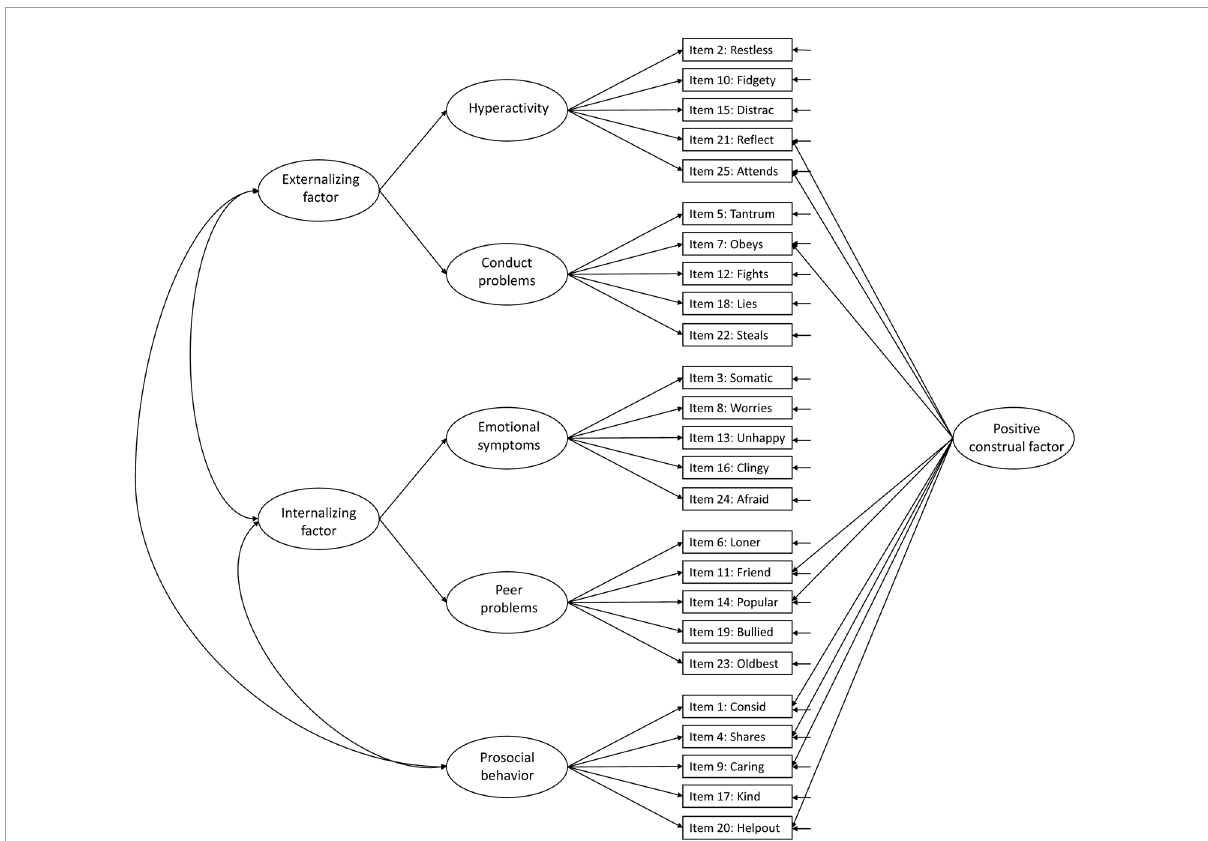
FIGURE5 Second-order model with internalizing and externalizing as second-order factors from the original five-factor structure with a positive construal method factor for the positively worded items (Model